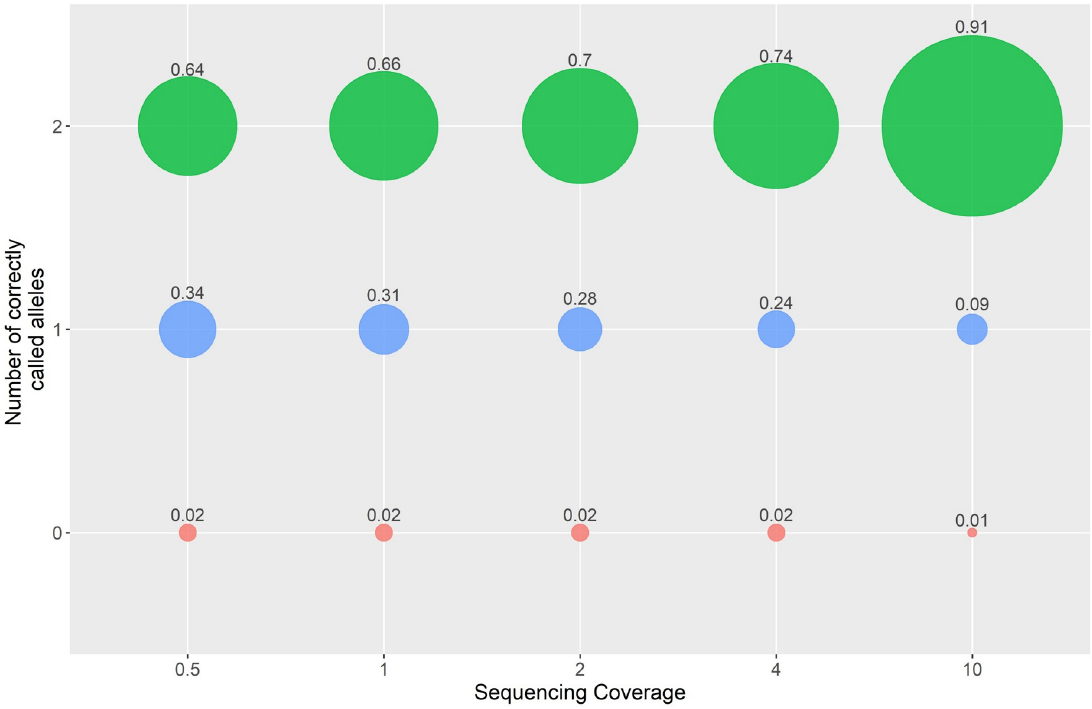
Fig 1. Proportion of genotype calls with both alleles correct (2), one allele incorrect (1) and two alleles incorrect (0) at different sequencing coverages. Two correctly called alleles (green) indicates no difference between the ONT genotype and SNP array genotype. One correctly called allele (blue) indicates one allele of the ONT genotype is correct and the other is incorrect. If both alleles are incorrect the (i.e., the alternate homozygous has been called) the number of correctly called alleles is zero